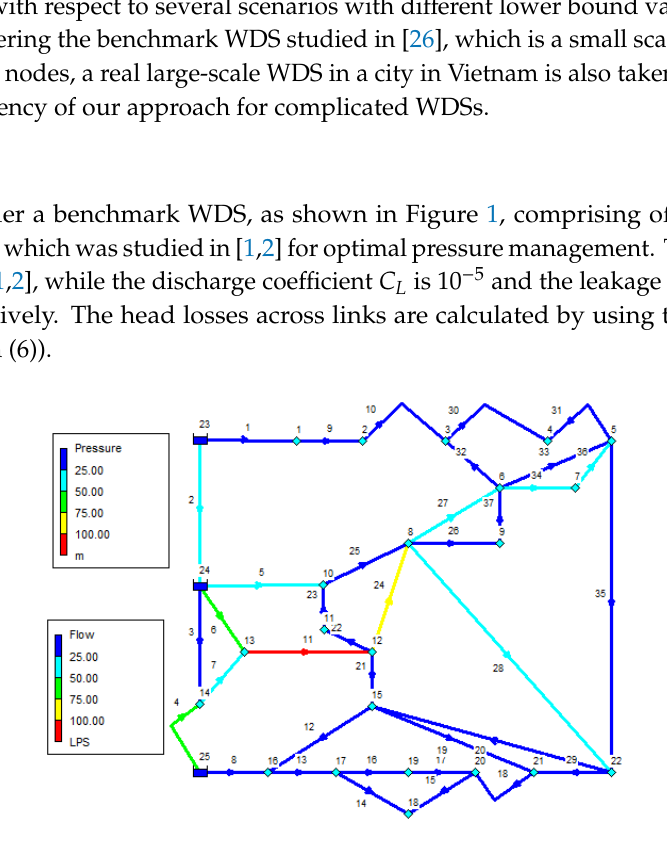
Figure 1. A Benchmark of a small water distribution system (WDS) [1].